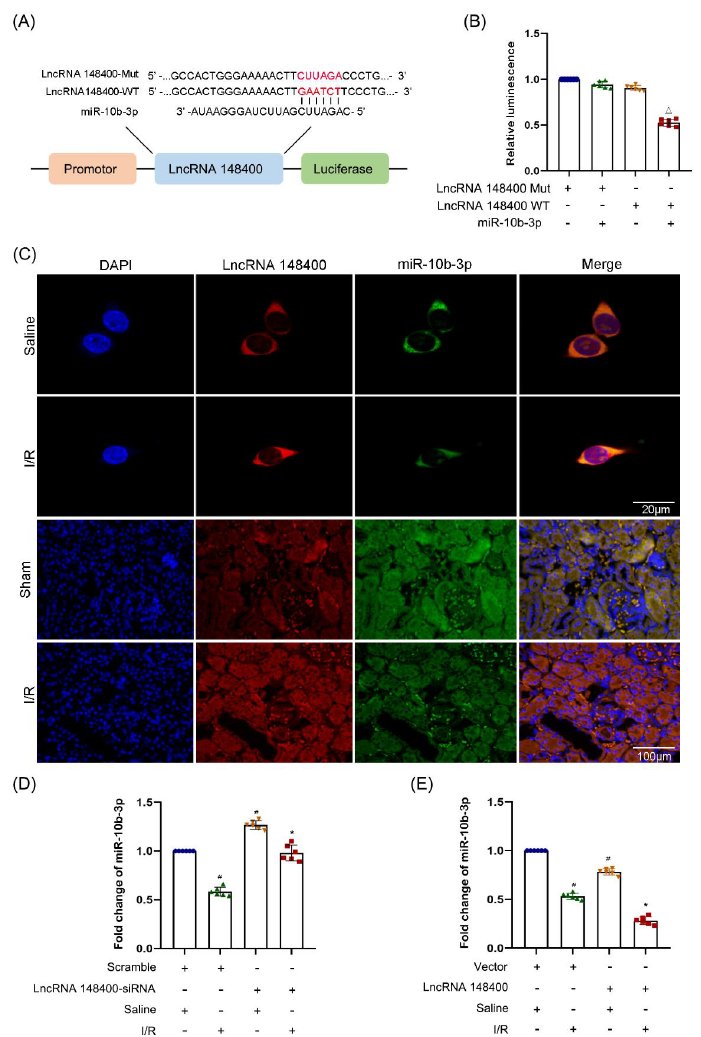
Figure 4. LncRNA148400 sponged miRNA − 10b − 3p in vitro and vivo. ( A ) Sequence alignment analysis of the complementary and mutated strand of LncRNA148400 and miRNA − 10b − 3p. ( B ) Detection of luciferase activities after co-transfection with lncRNA148400 − WT or lncRNA148400 − MUT plus with or without miRNA − 10b − 3p. ( C ) The FISH detection of intracellular co-localization of lncRNA148400 and miRNA − 10b − 3p in BUMPT cells and mice kidney under basic and I/R injury. ( D , E ) RT − qPCR analysis of the expression of miRNA − 10b − 3p. Data are expressed as mean ± SD ( n = 6). Δ p < 0.05 vs. co-transfection of miR−10b−3p mimic and LncRNA148400 WT or LncRNA 148400 − MUT groups. # p < 0.05 vs. saline with scramble group; * p < 0.05 vs. I/R with scramble group.